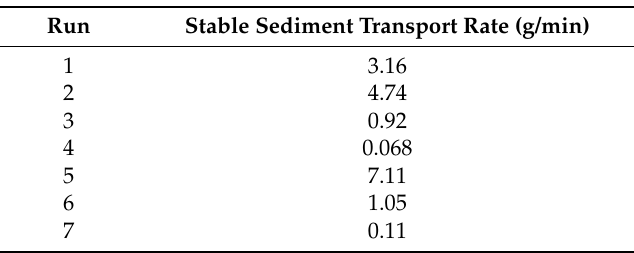
Table 5. Statistics of final stable sediment transport rate in different working conditions. Run Stable Sediment Transport Rate